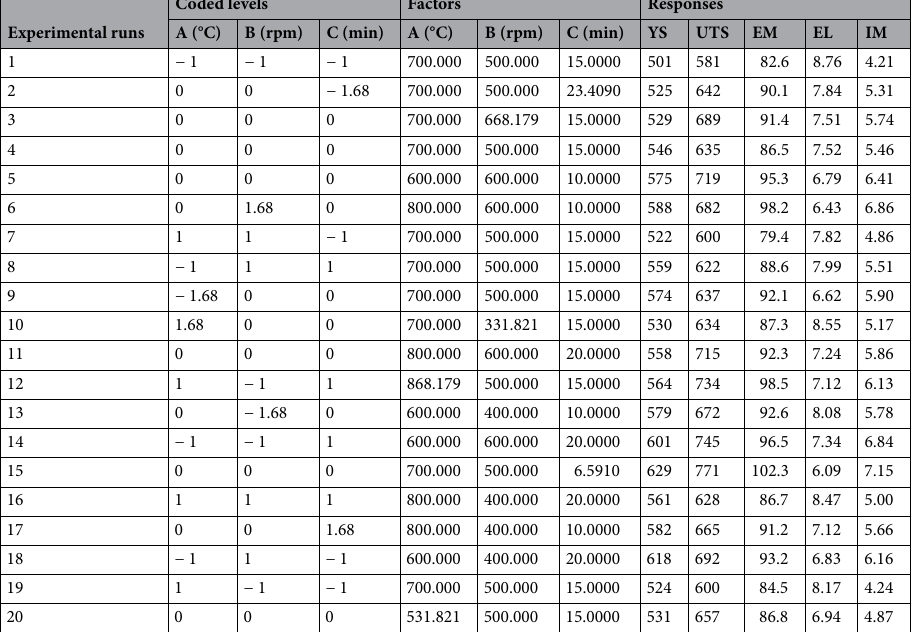
Table 4. Experimental runs, coded level, and responses. YS is the yield strength (MPa), UTS is the ultimate tensile strength (MPa), EM is elastic modulus (MPa), EL is elongation (%), and IM is impact strength